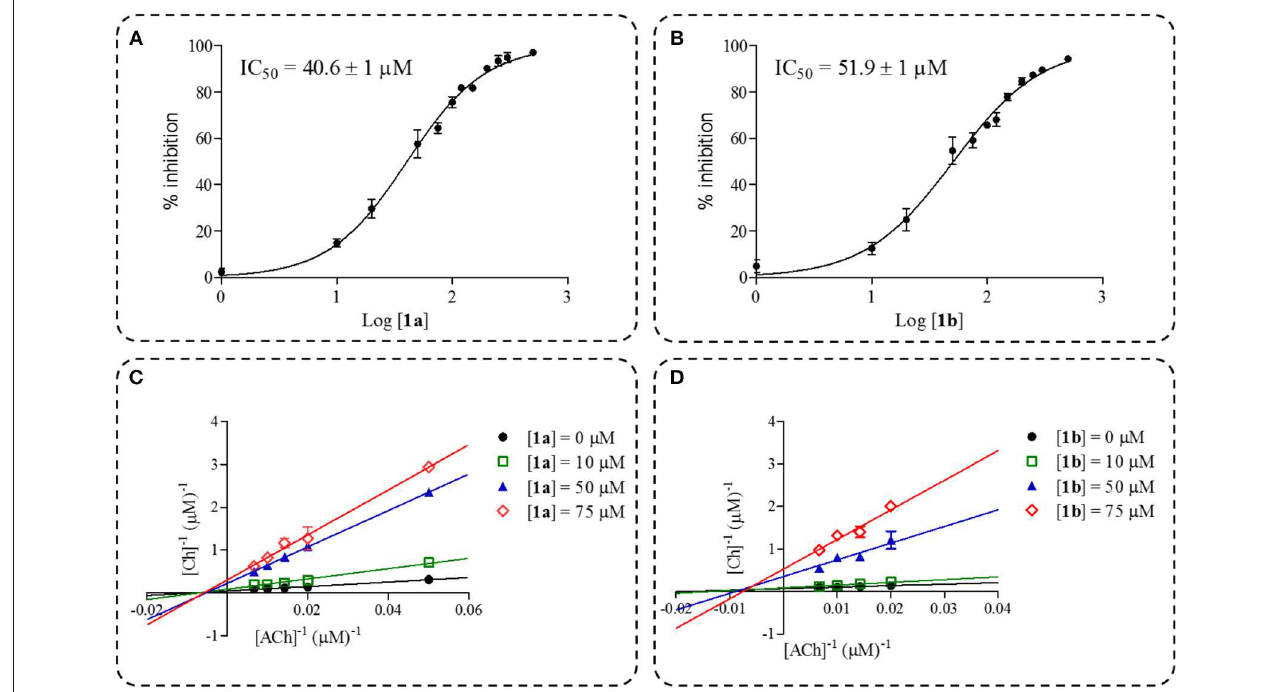
FIGURE 5 | Dose-response curve plots of inhibition percentage for compound 1a (A) and 1b (B) . Double-reciprocal plots for compound 1a (C) and 1b (D) .